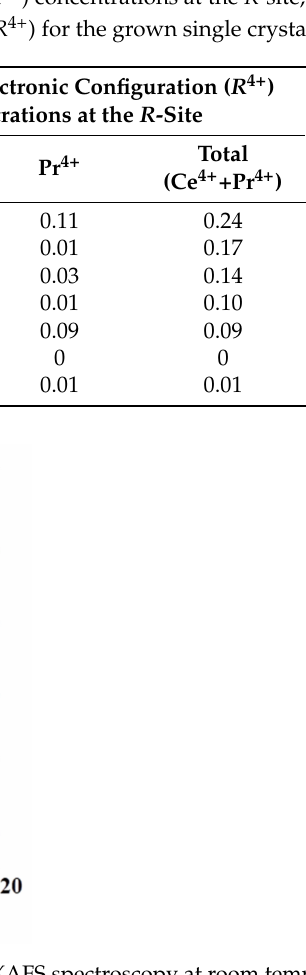
Figure 6. Pr L 3 -edge absorption spectra using XAFS spectroscopy at room temperature for the grown (La,Pr)OBiS 2 single crystals, Pr 2 S 3 and Pr 6 O 11 .